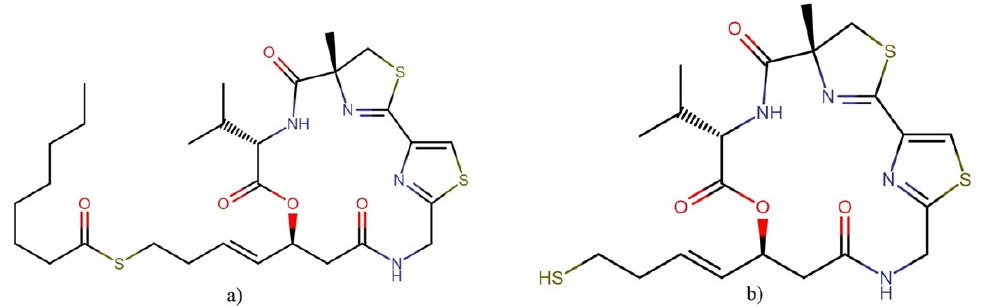
Figure 11. Chemical structures of ( a ) largazole and ( b ) largazole thiol.